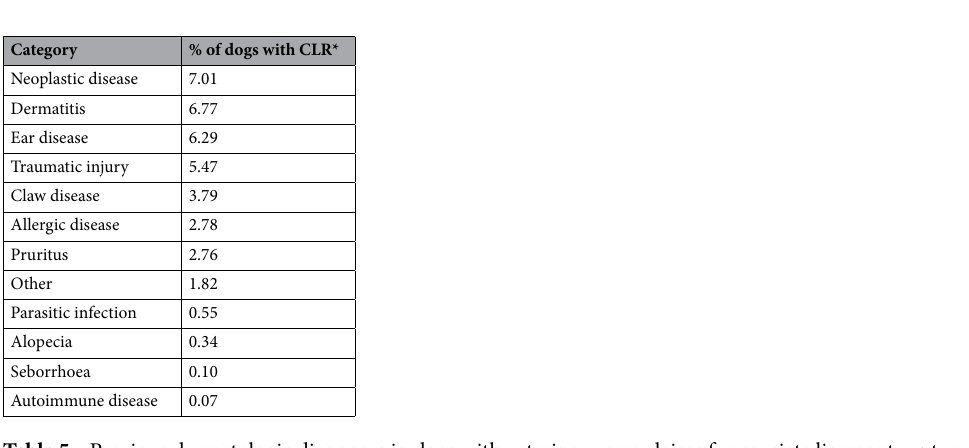
Table 5. Previous dermatologic diagnoses in dogs with veterinary care claims for cruciate ligament rupture (CLR) in Agria Pet insurance (2011–2016). *In total 4167 dogs with veterinary care claims for CLR.